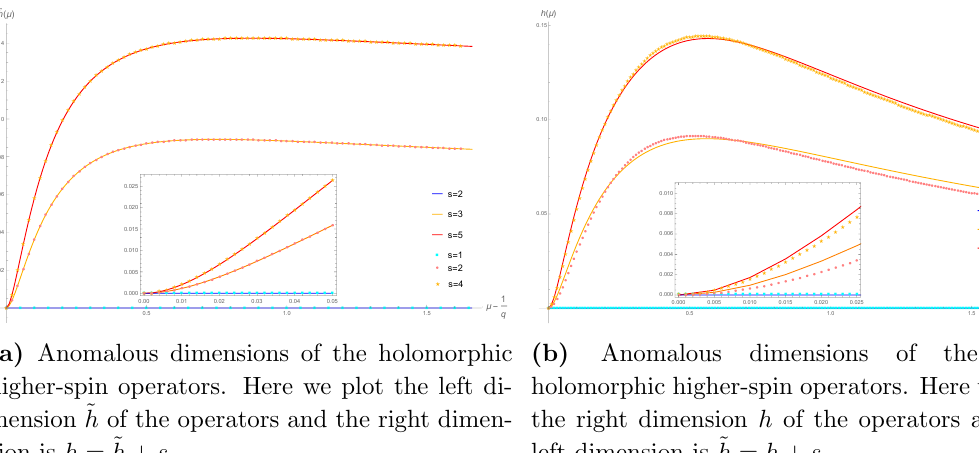
(a) Anomalous dimensions of the holomorphic higher-spin operators. Here we plot the left di- mension ~ h of the operators and the right dimen- sion is h = ~ h + s . Figure 7. The dimensions of operators with integer spins as a function of (cid:22) . The smaller (cid:12)gure in the frame zooms in to the bottom left corner of each large (cid:12)gure and shows that the anomalous dimensions of these operators approach zero in the limit (cid:22) ! ators in the symmetric channel, the discrete data points denote the operators in the antisymmetric channel. The plots are computed for q = 3. The N = (0 ; 2) supersymmetry is manifest in the plots.